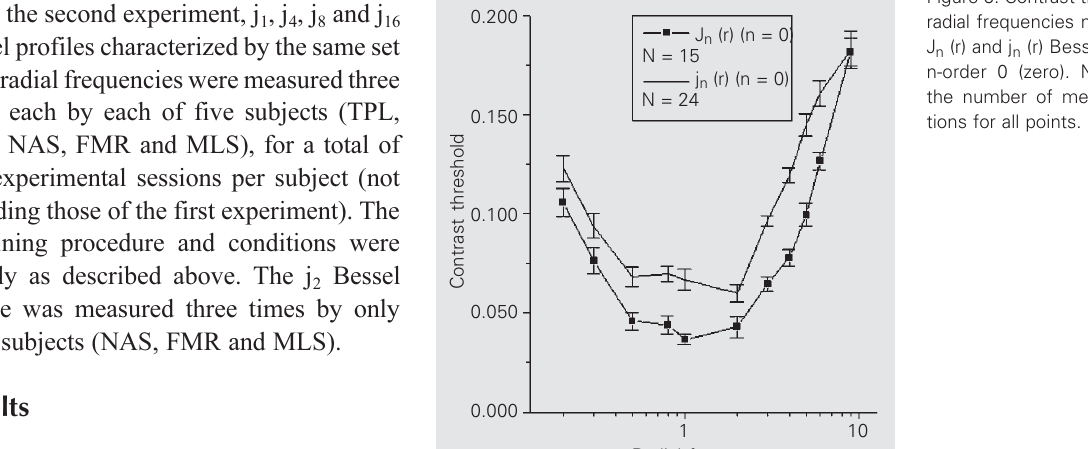
Figure 6. Contrast thresholds for radial frequencies modulated by J n (r) and j n (r) Bessel profiles of n-order 0 (zero). N represents the number of measured func- tions for all